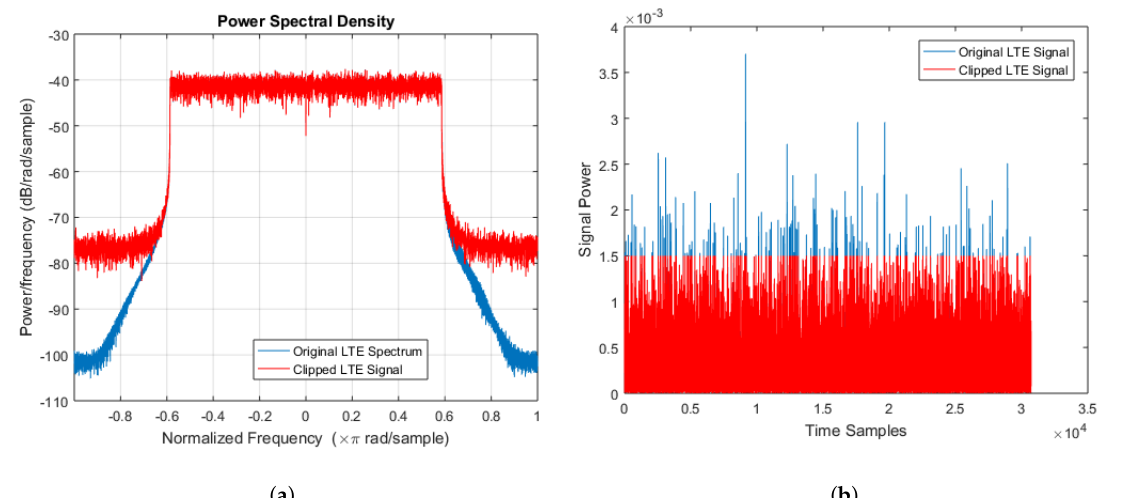
Figure 2. LTE signal spectrum with/without clipping technique ( a ); time domain LTE Signal with/without clipping technique ( b ).